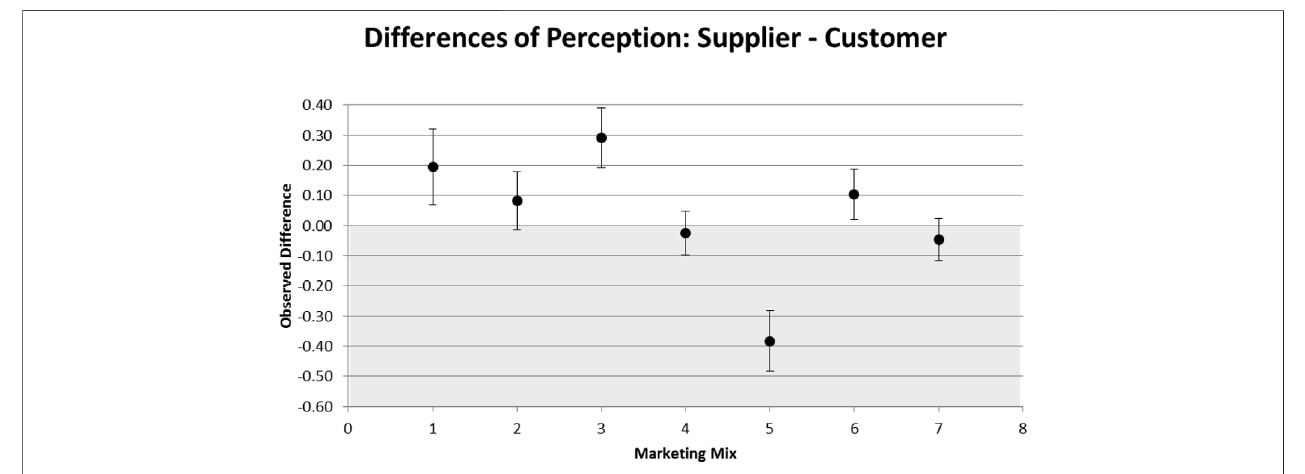
FIGURE 6 | Differences of perception between the supplier and